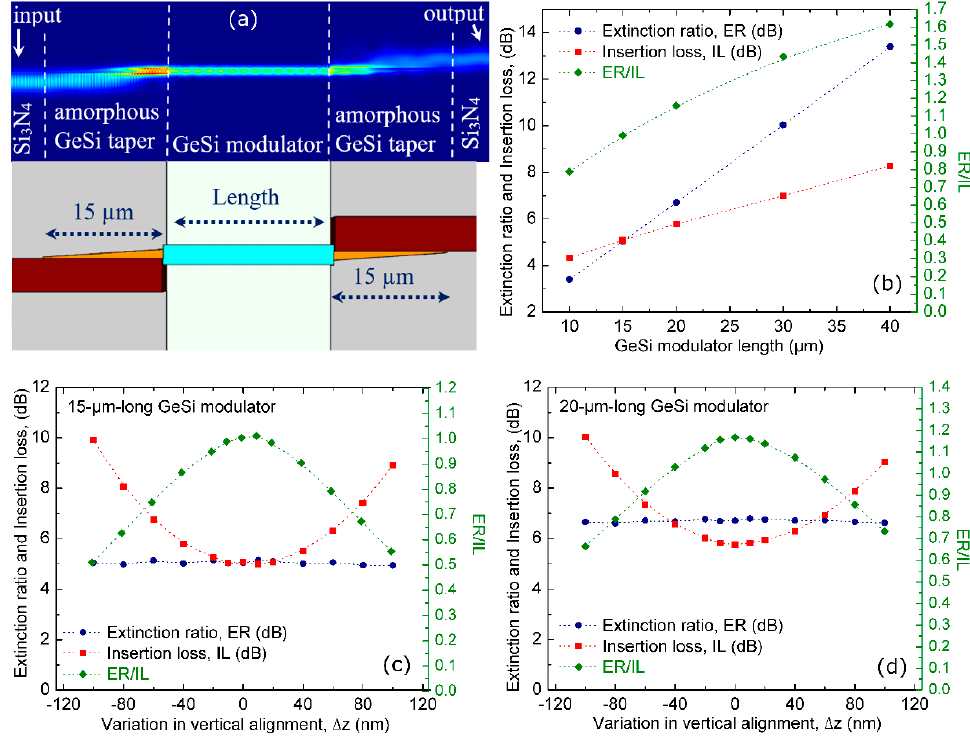
Figure 3. ( a ) Optical propagation from Si 3 N 4 input waveguide, amorphous Ge 0.83 Si 0.17 taper, Ge-based FKE optical modulator, and amorphous Ge 0.83 Si 0.17 taper to the Si 3 N 4 output waveguide. ( b ) Extinction ratio (ER) and insertion loss (IL) at different length values of the optical modulator. ER and IL with respect to the variation in the relative vertical positions between the amorphous taper and the Ge-based on Si optical modulator for ( c ) 15 µ m long and ( d ) 20 µ m long optical modulators, respectively.